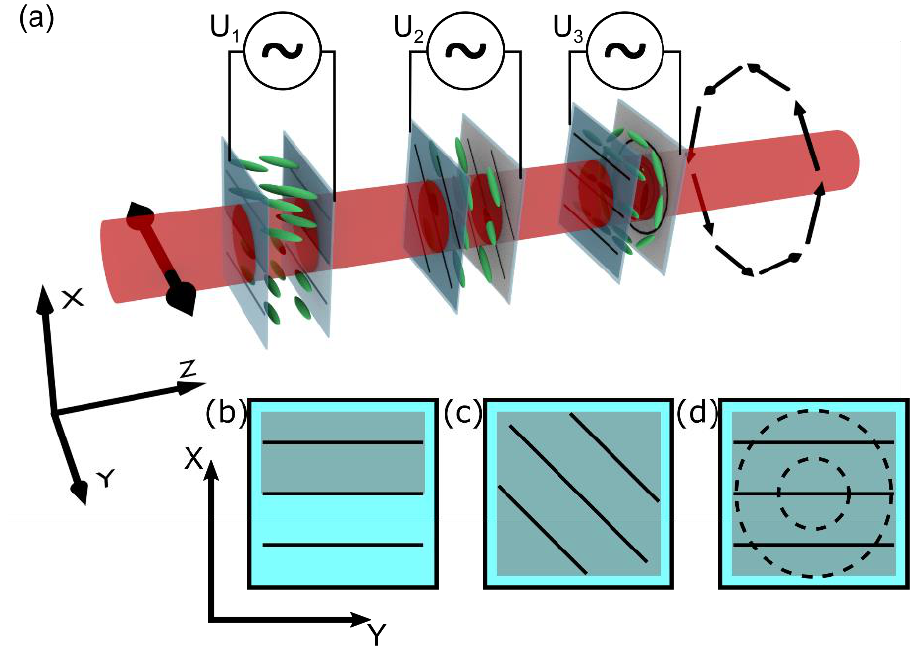
Figure 2. ( a ) Schematic representation of the NLC polarization converter composed of three in- dependent NLC cells, controlled by the external voltage; ( b ) π -phase retarder; ( c ) waveplate; and ( d ) θ -plate. Schematic representation of each cell presented in ( b – d ): solid (dotted) black lines indicate the alignment of molecules at the input (output) side, grey areas — ITO layer.